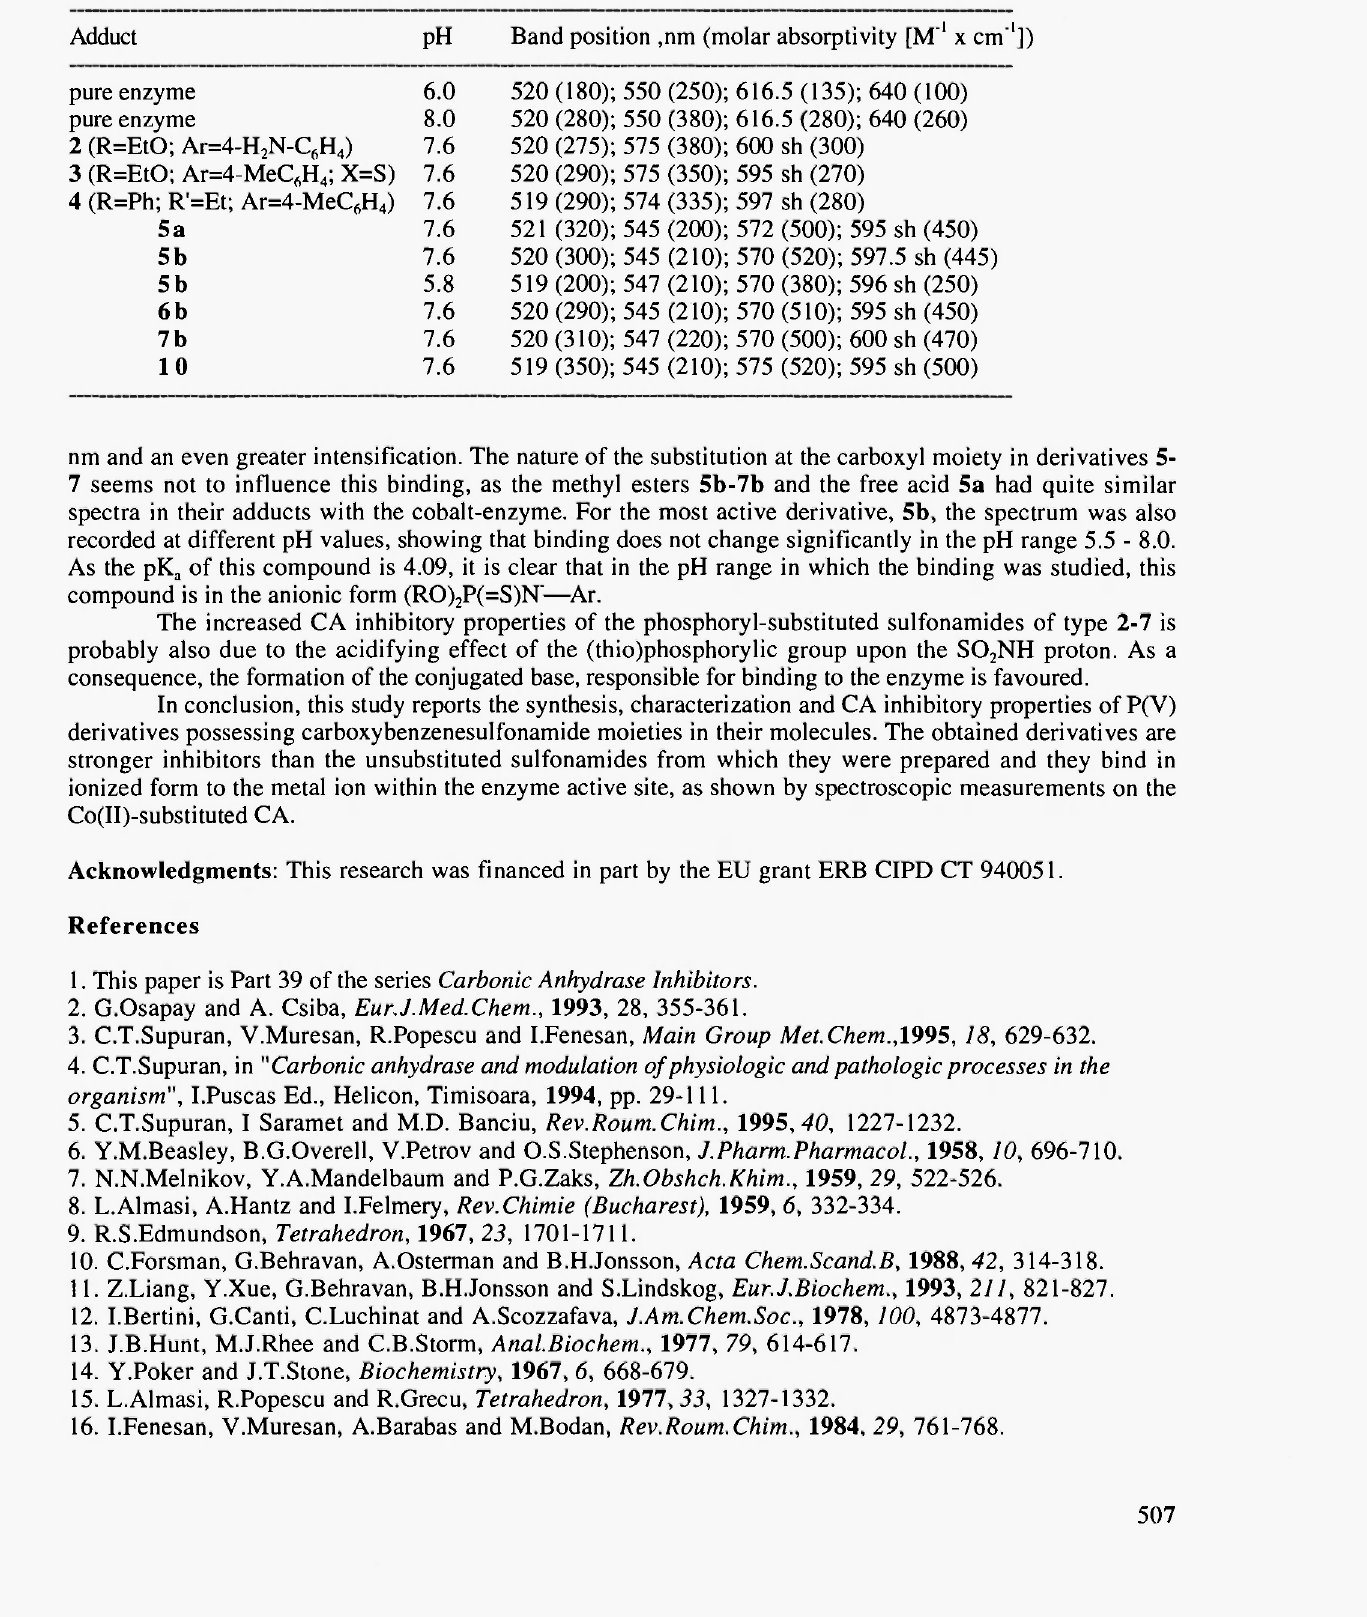
Table II: Electronic spectral data (in the range 400-750 nm) for adducts of Co(II)CA II with inhibitors 2-7 and 10. Enzyme concentrations were in the range 0.5-1.2 mM and pH values specified in each case. Inhibitor concentrations were in the range 1.0-1.5